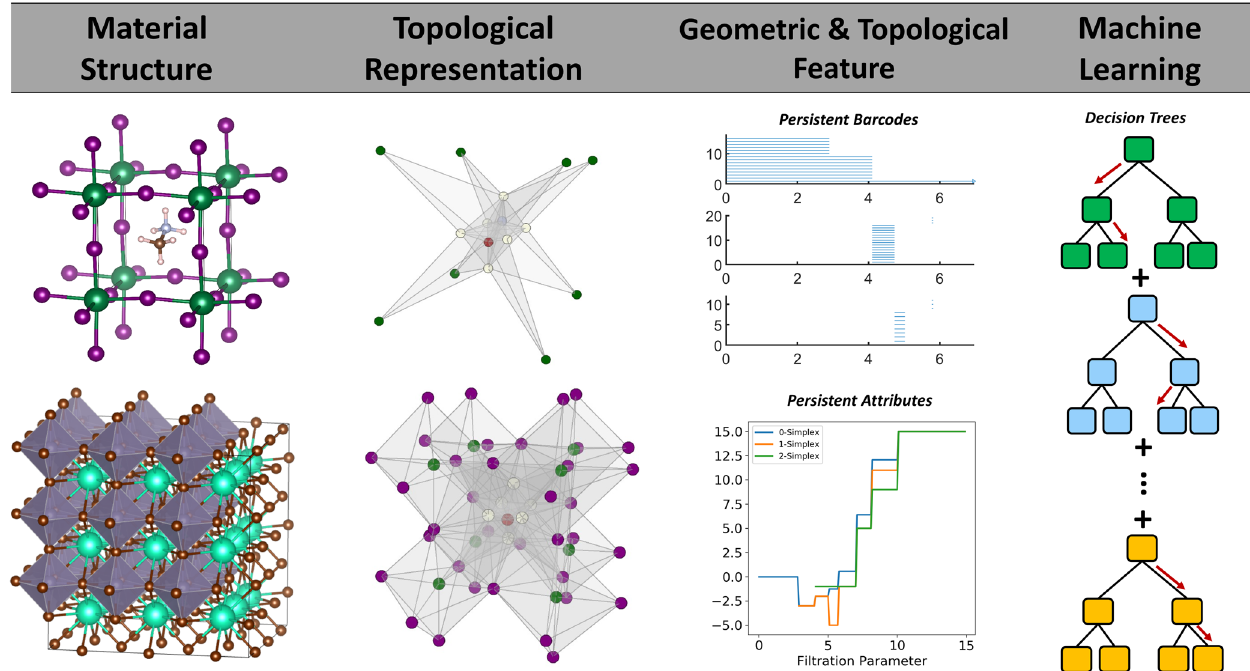
Fig. 4 The fl owchart of our PF-based machine learning models. The material structures are represented as simplicial complexes, based on which geometric and topological features are evaluated. The PF-based features, including PH fi ngerprint and PFC fi ngerprint, are combined with machine learning models, in particular GBT, to predict material